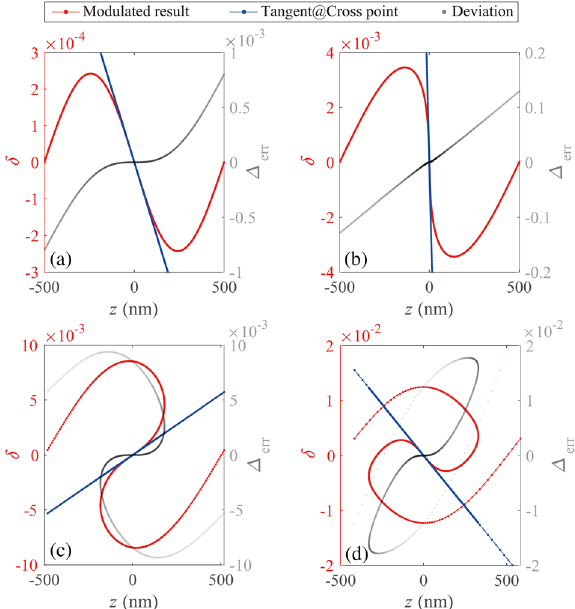
0 , there exists an optimized